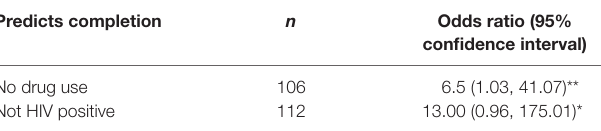
TaBle 7 | Model predicting treatment completion: Yuma cases ( R 2 = 0.1017, n = 114). Predicts